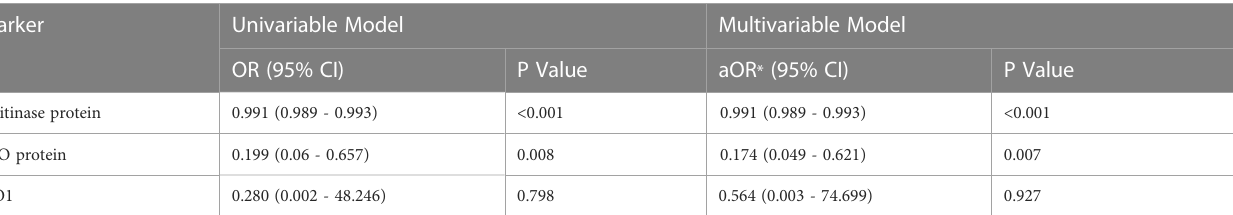
Classi fi cation and regression trees (CART) models were employed to identify the cut-off points for chitinase protein and IDO protein which best separated cases from controls (Figure 4).